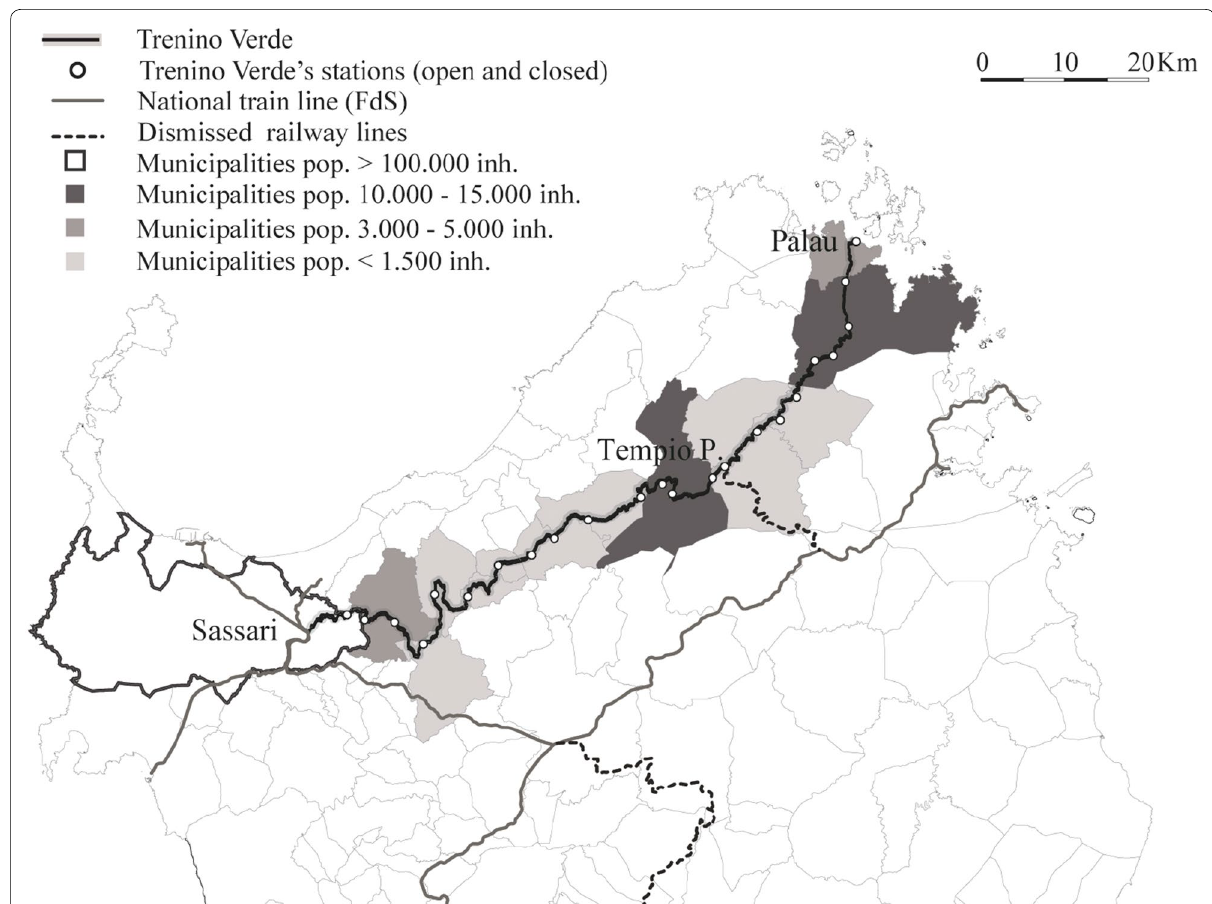
Fig. 7 Map of municipalities along the Trenino Verde line and intersection with national train